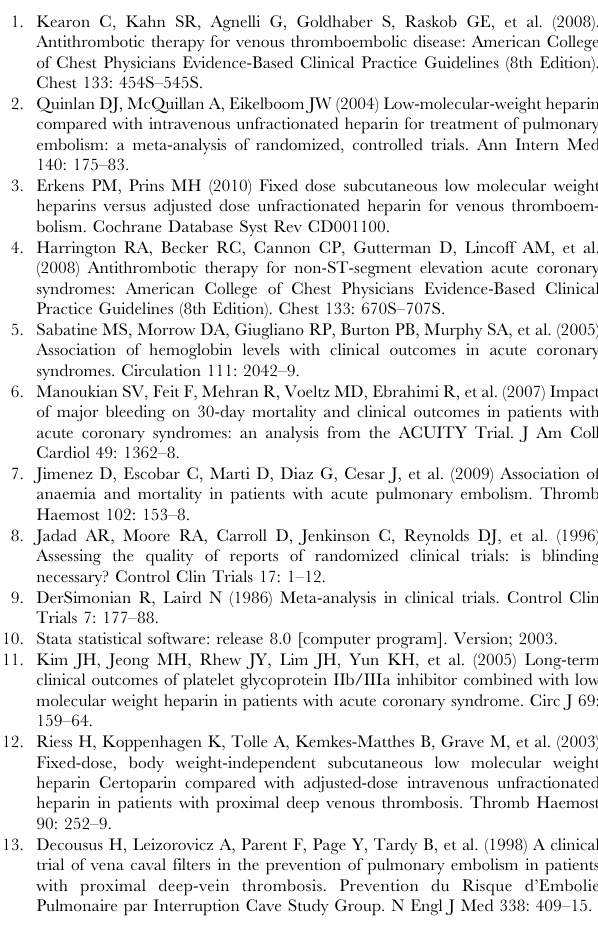
Figure S1 Subgroup analysis: number of daily LMWH administrations (once daily vs twice daily).